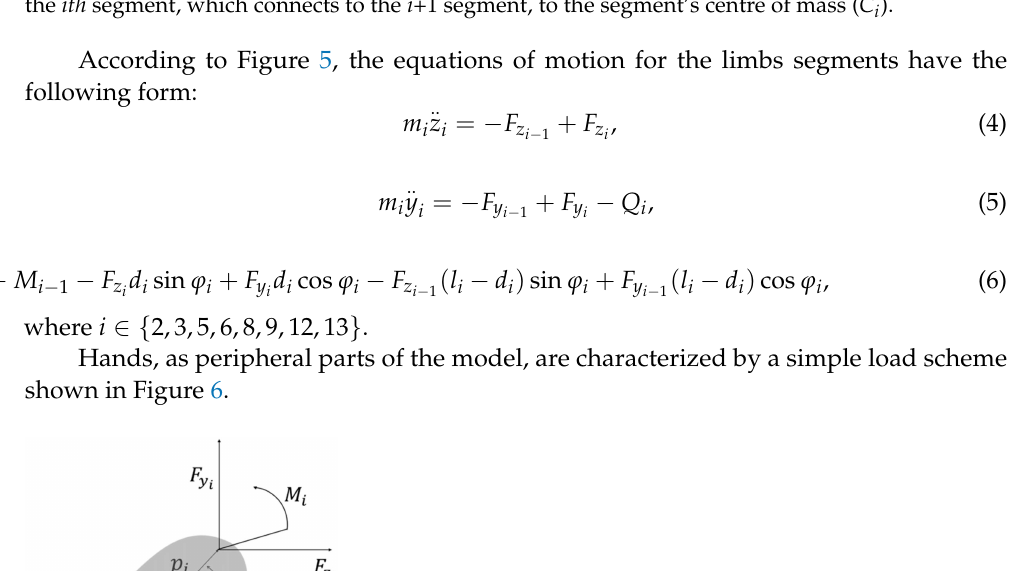
Figure 5. Free-body diagram representative for the segments standing for shanks, thighs, arms, and forearms. The symbols used mean: i —segment number, which takes one of the following values: 2, 3, 5, 6, 8, 9, 12, 13 (according to Figure 3), l i —length of the ith segment, and d i —distance from the end of